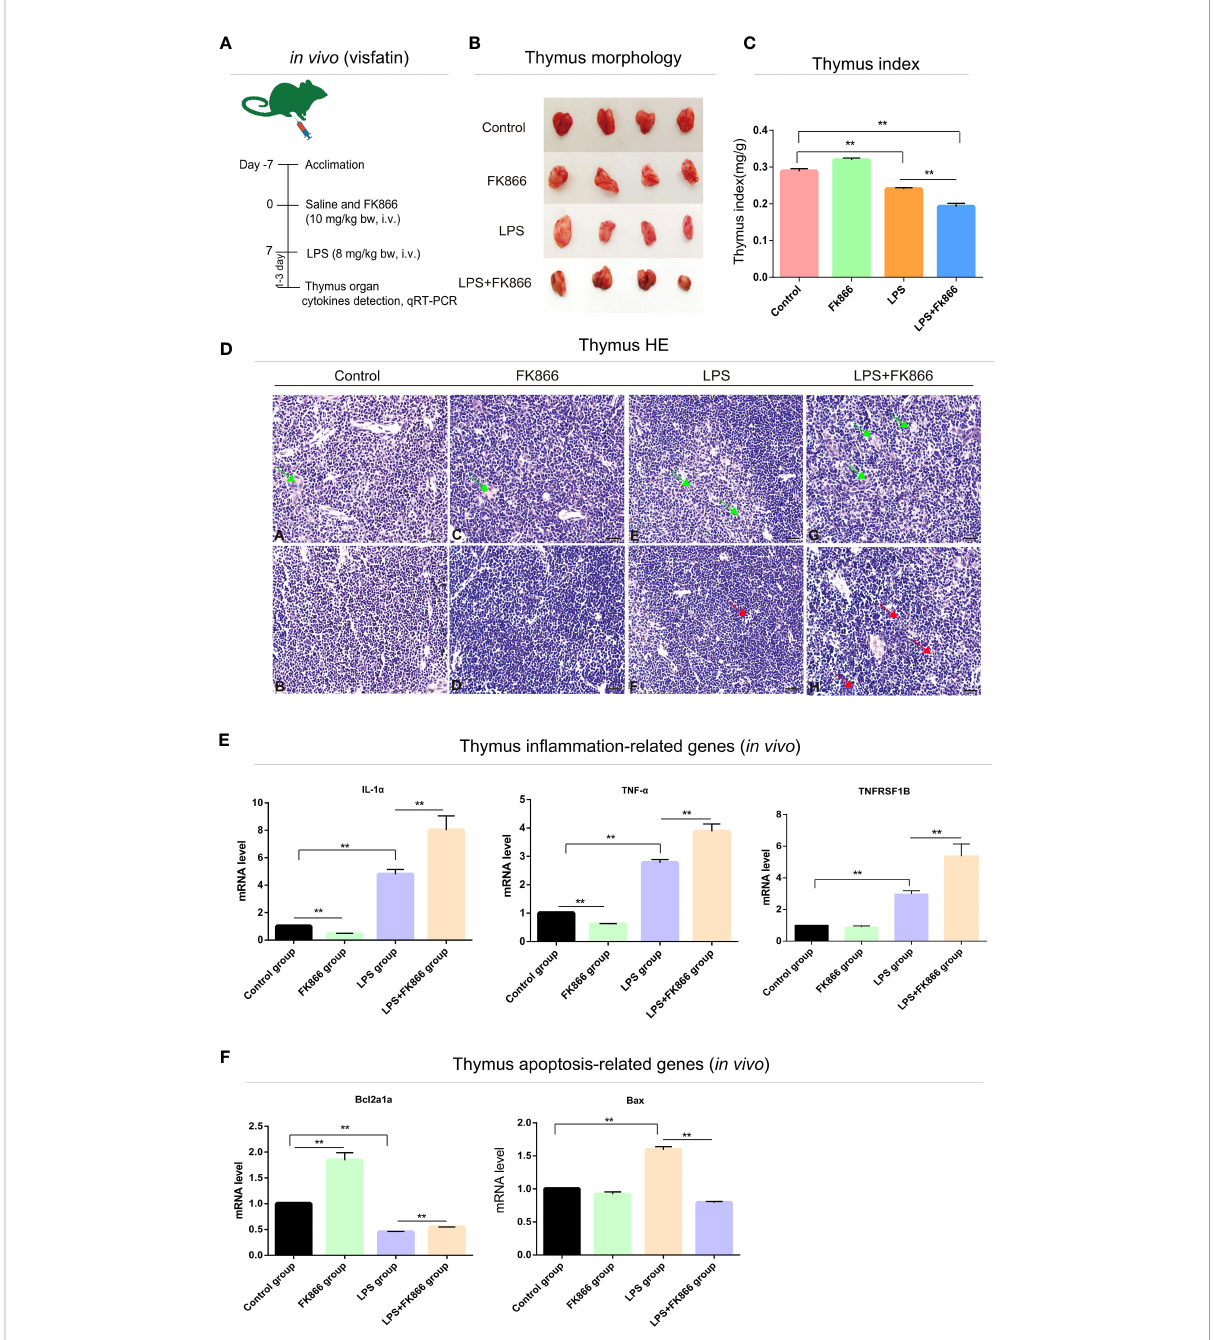
FIGURE 4 Effects of endogenous visfatin on in fl ammation and apoptosis in mice thymus. (A) Experimental timeline of the exogenous FK866 (10 mg/kg bw, i.v.) and LPS (8 mg/kg bw, i.v.) treatment in mice ( n =10 per group, in vivo ). (B) Gross lesions of the mice thymus in different treatment groups. (C) Thymus index of different treatment groups (** P <0.01). (D) Histological analysis mice thymus in different treatment groups. Green arrows point to thymic bodies, red arrows point to apoptotic bodies. Thymus medulla (A) and cortex (B) in control group; Thymus medulla (C) and cortex (D) in FK866 group; Thymus medulla (E) and cortex (F) in LPS group; Thymus medulla (G) and cortex (H) in LPS+FK866 group. (E) qRT- PCR detection of the mRNA expression levels in in fl ammation-related cytokines of the mice thymus in different treatment groups (** P <0.01). (F) qRT-PCR detection of the mRNA expression levels in apoptosis-related cytokines of the mice thymus in different treatment groups (** P